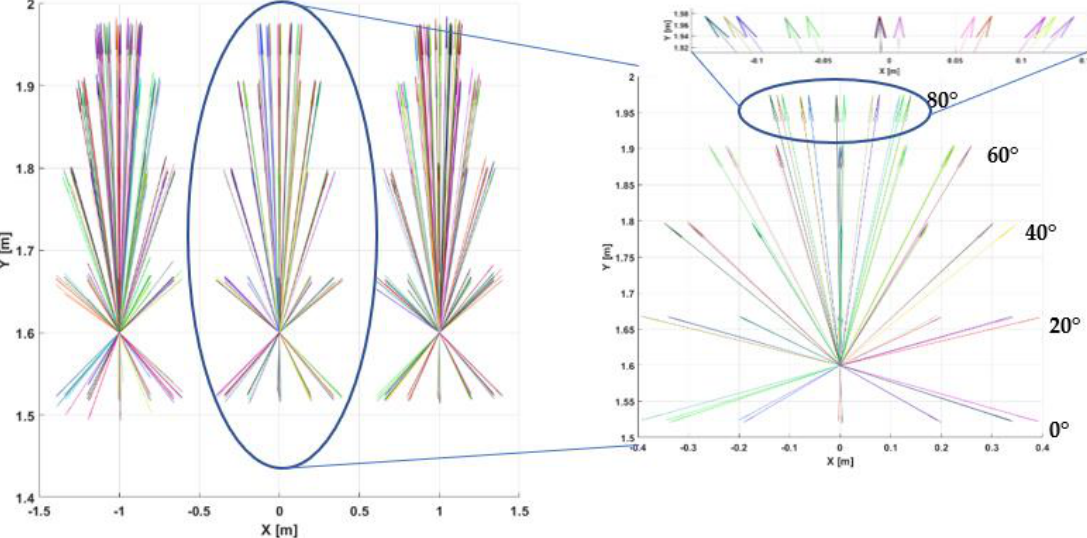
Figure 10. Vectors indicating the direction in which the launcher was facing during the measurements (side view).